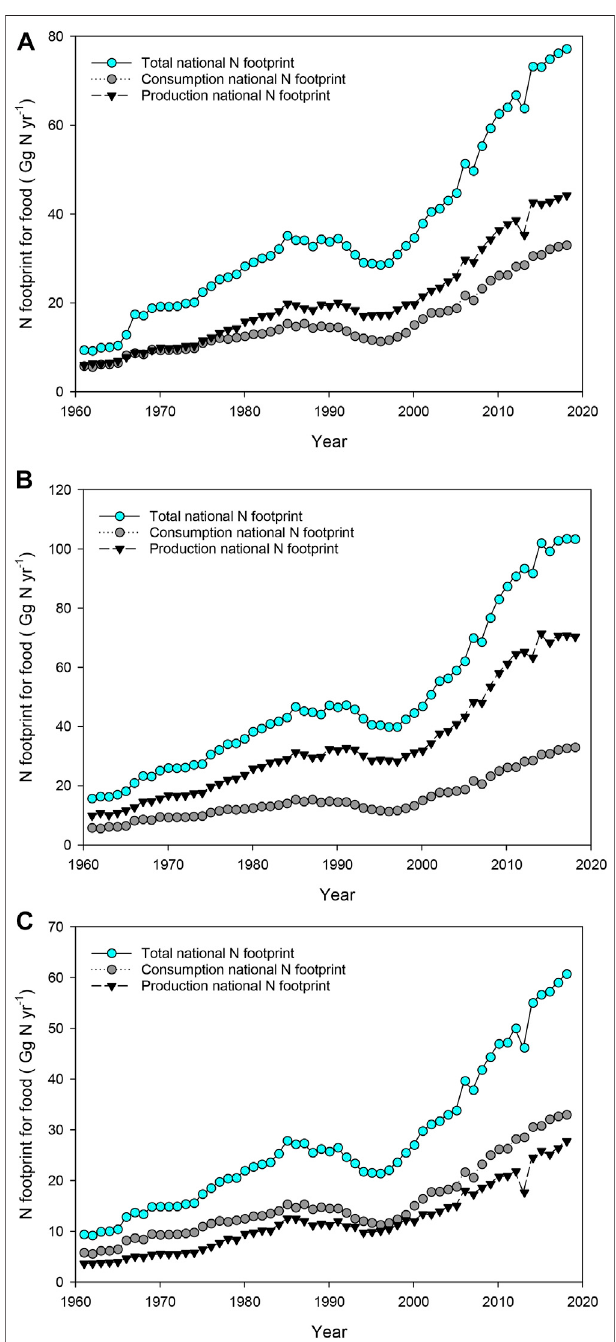
FIGURE 8 | Mean national N footprint for food (combined scenario) (A) , fertilized scenario (B) and unfertilized scenario (C) in Rwanda.